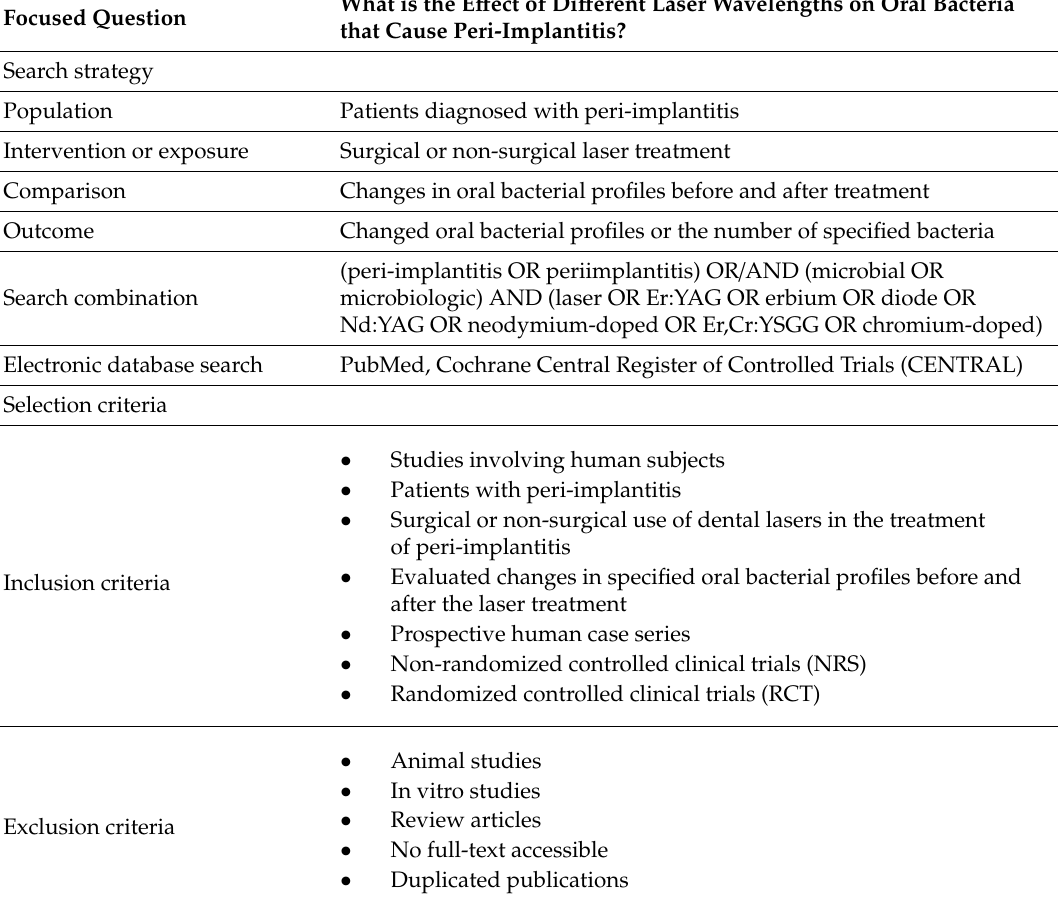
Table 1. Systematic Search